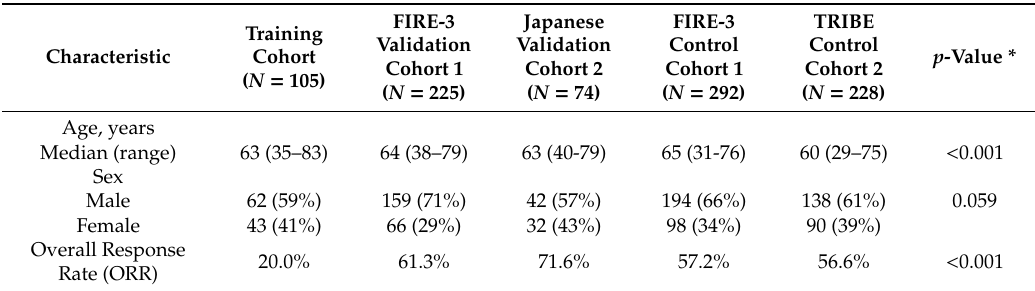
Table 1. Baseline patient and tumor